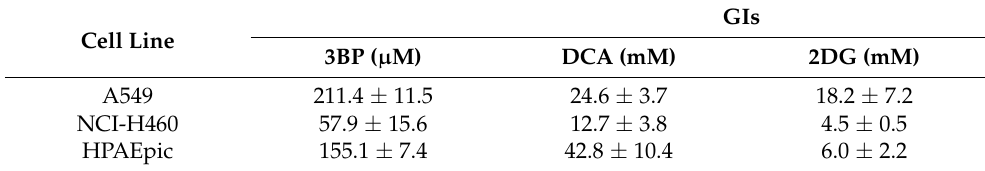
Table 1. IC 50 values of DCA, 3BP and 2DG for A549, NCI-H460 and HPAEpic cell